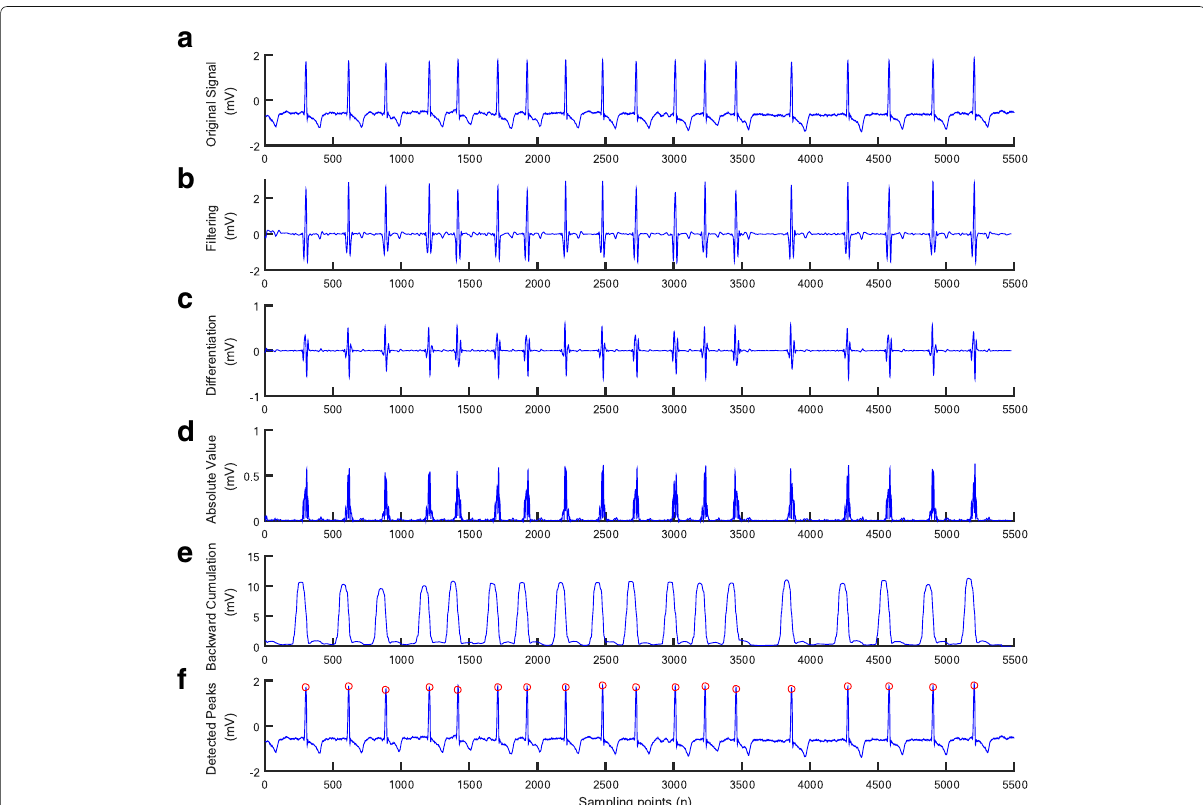
Fig. 5 Result after performing each stage of the proposed method for the ECG with baseline wander and sudden changes (ECG recording 219). a ) Original signal. b ) Filtering. c ) Differentiation. d ) Absolute value. e ) Backward cumulation. f ) Detected